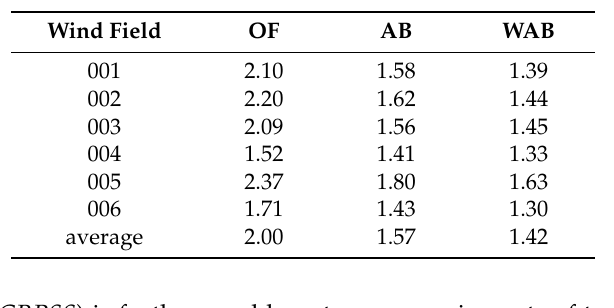
Figure 6. Rank histogram of ensemble forecasts, including original forecast (OF), and predictions from average bias correction (AB) and weather adapted bias correction (WAB). The black line with marks “+” is the ideal flat distribution. In the upper panel of Figure 6, the rank histogram of original forecast (OF) has an “L” shaped distribution, which means the dominant part of ensemble members have larger prediction values than observation. The middle panel shows that the errors of predictions are effectively reduced after